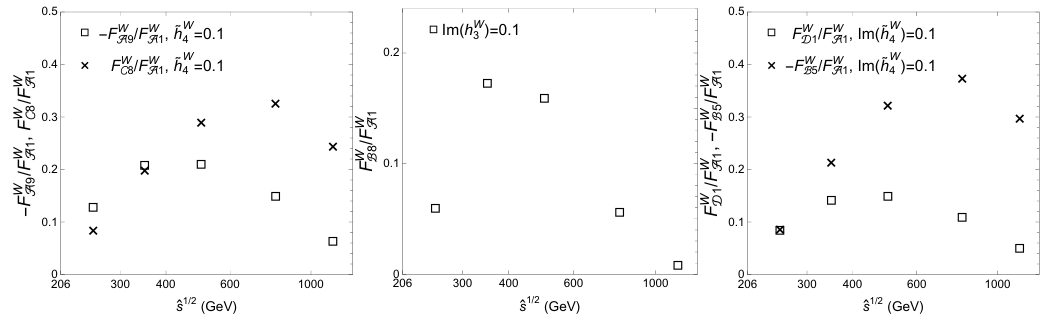
Figure 8 . In the left panel, the 2 coe(cid:14)cients F W ( 2 ) and F W ( ) divided by F W are shown for A 9 C 8 A 1 (cid:0) (cid:2) e h W 4 = 0 : 1. These 2 coe(cid:14)cients are constrained to be identically zero by CP invariance. In the middle panel, the coe(cid:14)cient F W divided by F W are shown for h W = 0+0 : 1 i . This coe(cid:14)cient is constrained 3 B 8 A 1 to be identically zero by CP e T invariance. In the right panel, the 2 coe(cid:14)cients F W ( 2 ) and F W D 1 B 5 (cid:0) ( ) divided by F W are shown for e h W = 0 + 0 : 1 i . These 2 coe(cid:14)cients are doubly constrained to be 4 A 1 (cid:2) identically zero by CP invariance and CP e T invariance. For each result, the values in the 5 bins, from left to right, are obtained after integration over ^ s in the regions ( m + m ) < ^ s 1 = 2 < W H